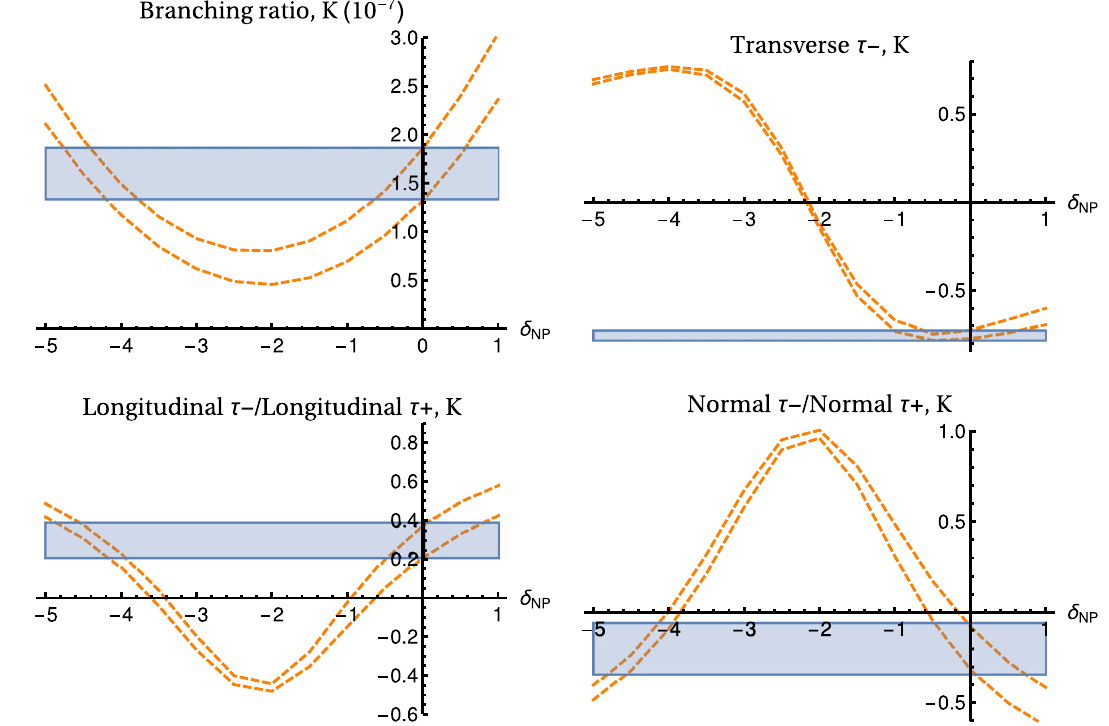
= − δ C = − C (cid:8) ≡ δ 10 NP , whose values are given in the horizontal axes. See Fig. 7 9 10